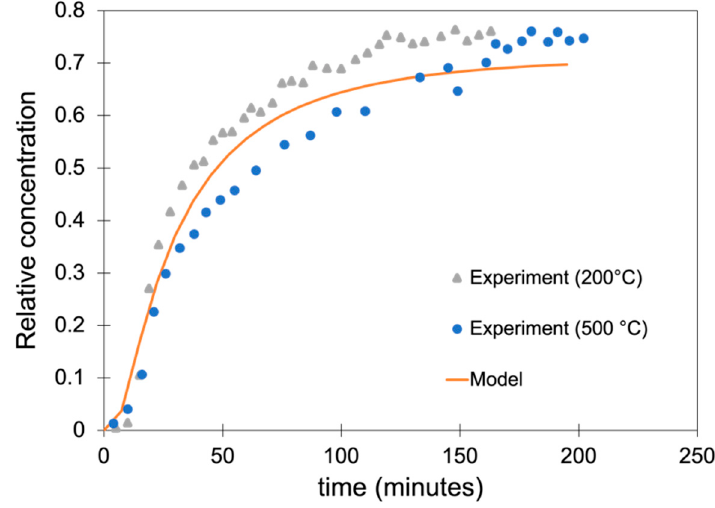
Figure 5. Breakthrough curve of 1 g/L TC solution through the geofilter prepared with stevensite treated at 200 °C (grey triangles) and 500 °C (blue circles). STANMOD curve fitting is presented by the orange line.